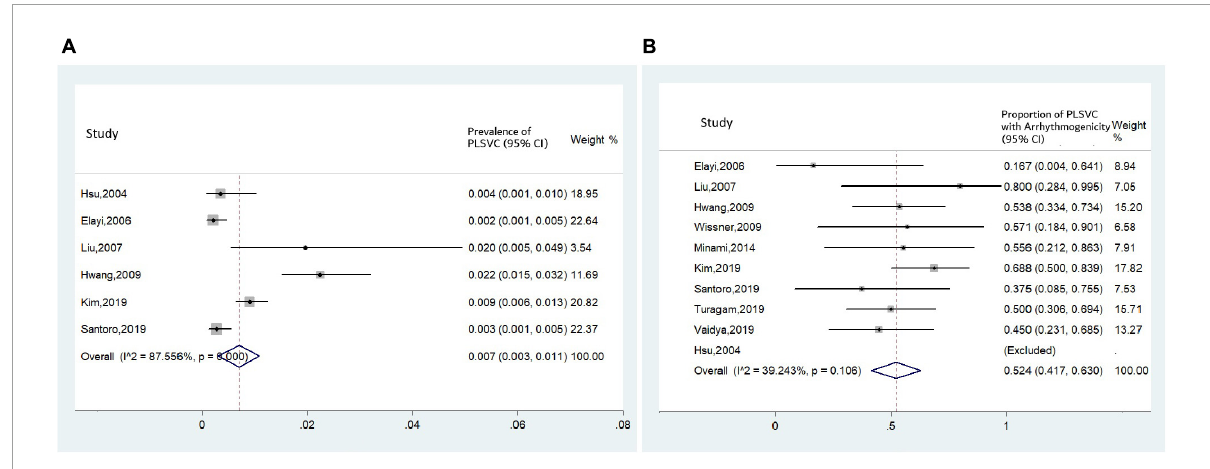
FIGURE5 Forest plots assessing (A) prevalence of PLSVC in patients with AF receiving CA, and (B) proportion of arrhythmogenic